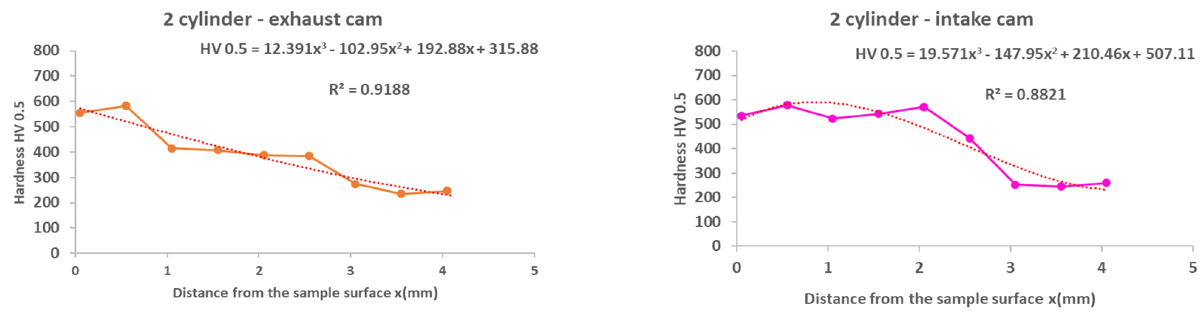
Figure 14. Regression analysis for a 3rd − order polynomial for the values of the 2nd cylinder on the exhaust and intake cams.